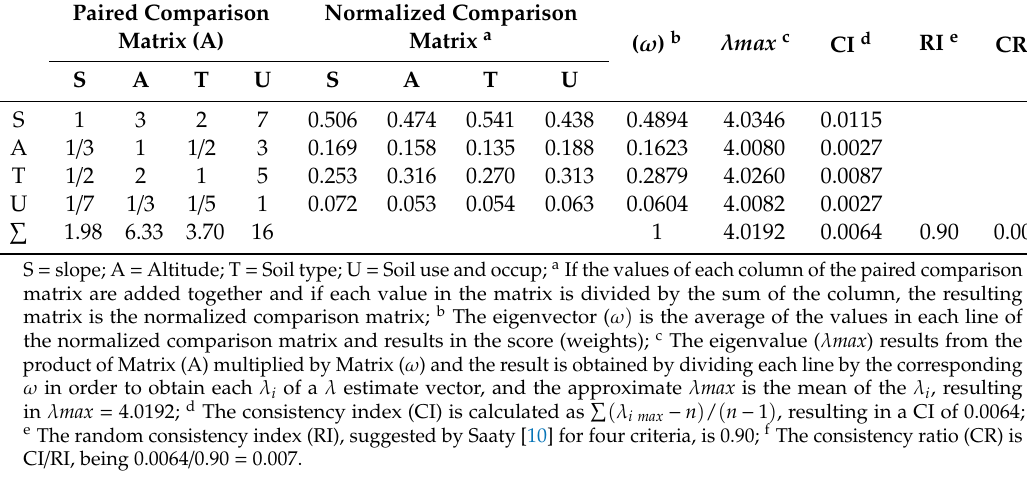
Table 5. Paired comparison matrix to evaluate the relative importance of the sub-criteria used to identify areas suitable for fish